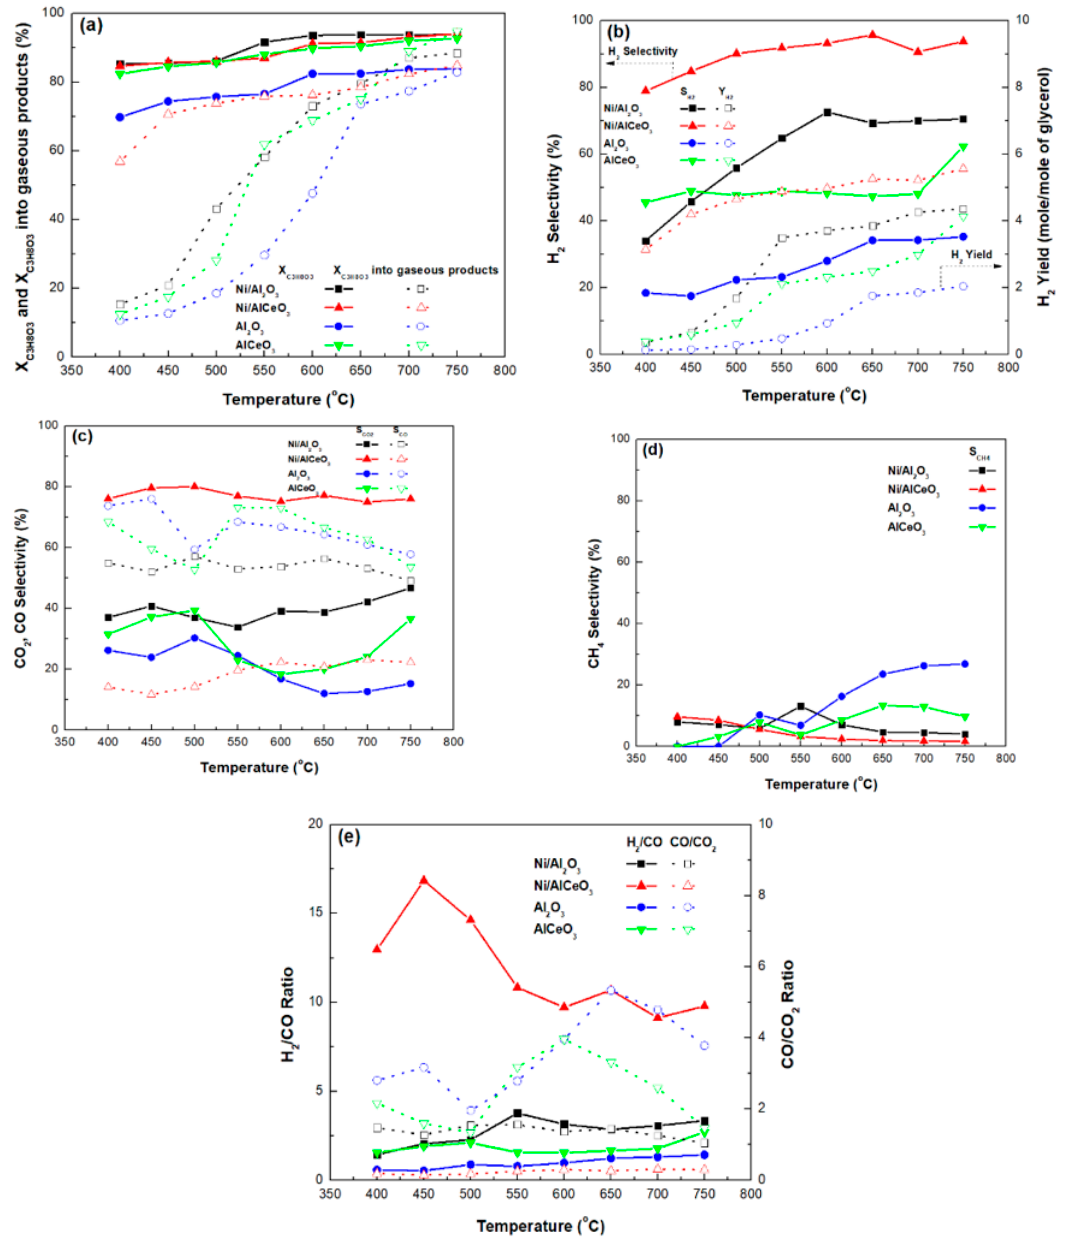
Figure 7. ( a ) Total glycerol conversion and glycerol conversion into gaseous products, ( b ) H 2 selectivity and H 2 yield, ( c ) CO 2 and CO selectivity, ( d ) CH 4 selectivity, and ( e ) H 2 / CO and CO / CO 2 molar ratios (samples tested under experimental protocol #1).